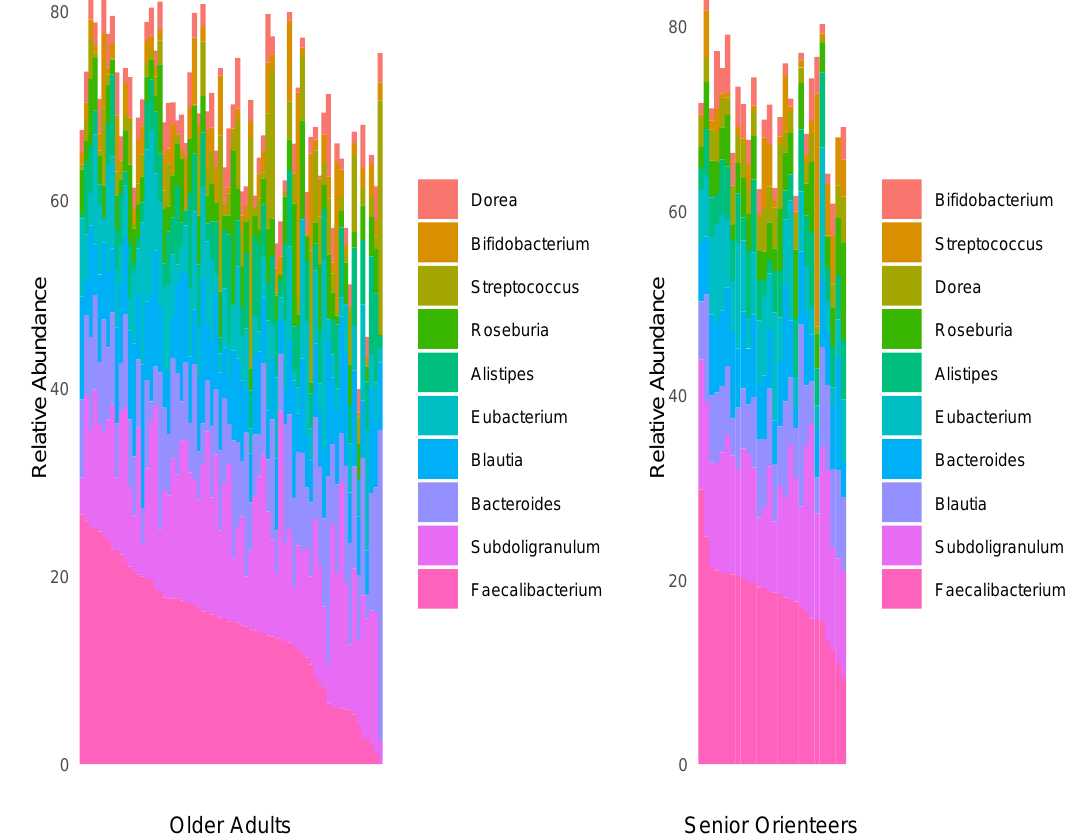
Figure 2. Relative abundance of the 10 most abundant genera across 98 samples.